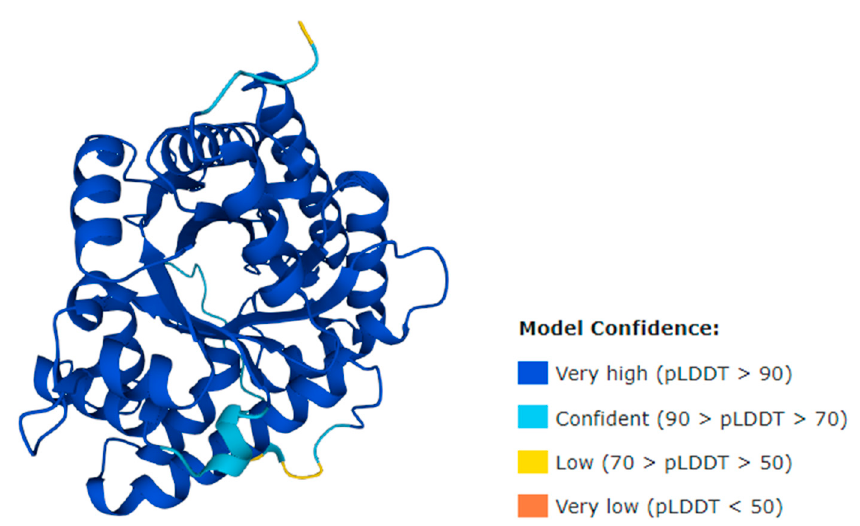
Figure 11. Fructose-bisphosphate aldolase develops based on structure modelling.